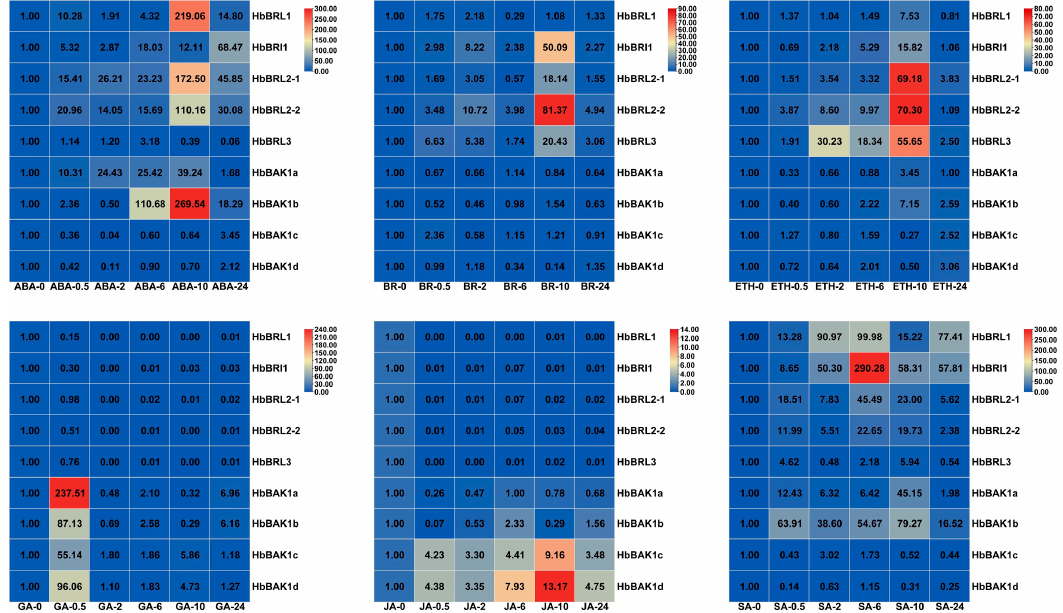
Figure 7. HbBRI1 and HbBAK1 response to different hormones (ABA, BR, ETH, GA, JA, SA). ABA, abscisic acid; BR, brassinosteroid; ETH, ethylene; GA, gibberellin; JA, jasmonic acid; SA, salicylic acid. Error bar indicates SD, which represents the standard deviation of three independent experiments. HbActin was the reference gene. Hormones treatment for temporal showed in X-axis. Expression values are shown in different colored boxes. Blue and red represent low and high expression levels, respectively.